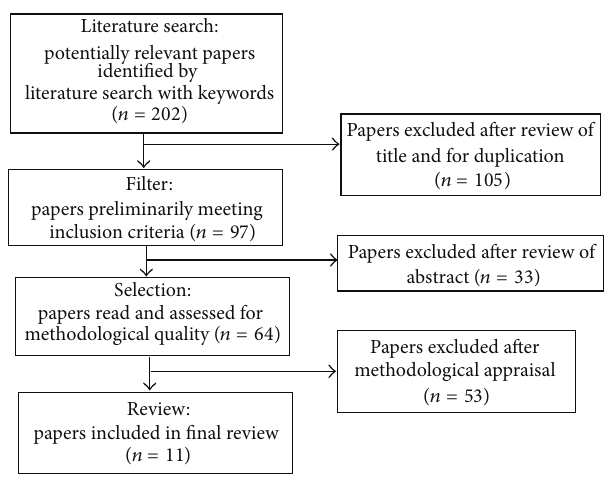
Figure 1: Flow diagram of the literature selection